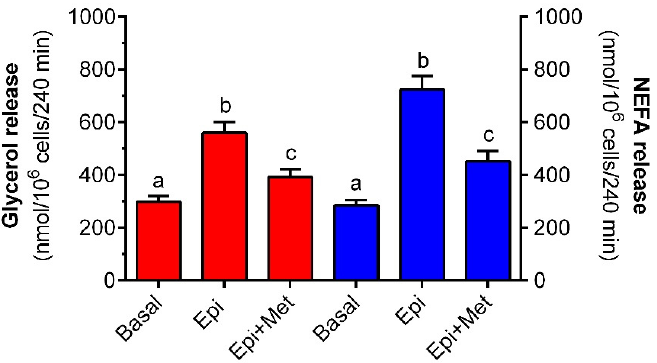
Figure 5. The effects of metformin on DPCPX-induced glycerol release in isolated rat adipocytes in the presence of low and high concentrations of glucose. Adipocytes were preincubated for 3 h with or without 1 mM metformin in the buffer containing 3 mM glucose (red bars) or 12 mM glucose (blue bars). Then, 0.5 µM DPCPX was added to all cells (except for basal) and incubations were performed for an additional 1 h. After the end of the incubations, adipocytes were removed and the glycerol content in the buffer was determined. DPCPX—8-Cyclopentyl-1,3-dipropylxanthine, Met—metformin. The obtained results represent the mean ± SEM from 3 independent experiments in 5 repetitions ( n = 15). Values marked by different letters within each experimental group differ significantly at p < 0.05.